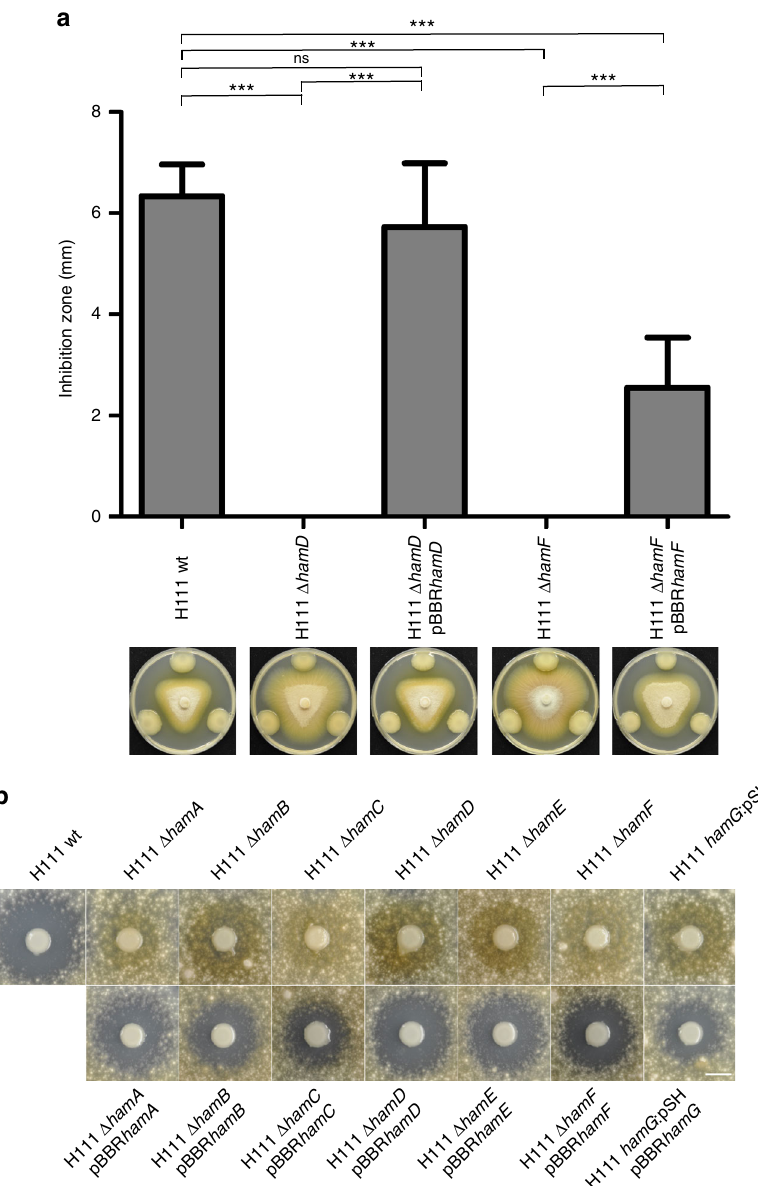
Fig. 2 Antifungal activity is dependent on fragin, the biosynthetic product of the ham gene cluster. a Antifungal activity of the wild type (H111 wt), the hamD mutant (H111 Δ hamD ), the hamF mutant (H111 Δ hamF ), and the trans -complemented mutants (H111 Δ hamD pBBR hamD and H111 Δ hamF pBBR hamF ). Results are represented as mean and error bars represent SD. Statistical analysis was performed with one-way ANOVA and Tukey ’ s multiple comparison as post test. ns, not signi fi cant. Signi fi cance is indicated by three stars. *** p < 0.001. n = 9. Representative pictures of the antifungal assays are shown below the respective bars. b Antifungal activity is lost in single ham deletion mutants and partially restored in the respective trans -complemented mutants. Representative pictures of antifungal spray assays against the fungus F. solani are shown. Scale bar indicates 10